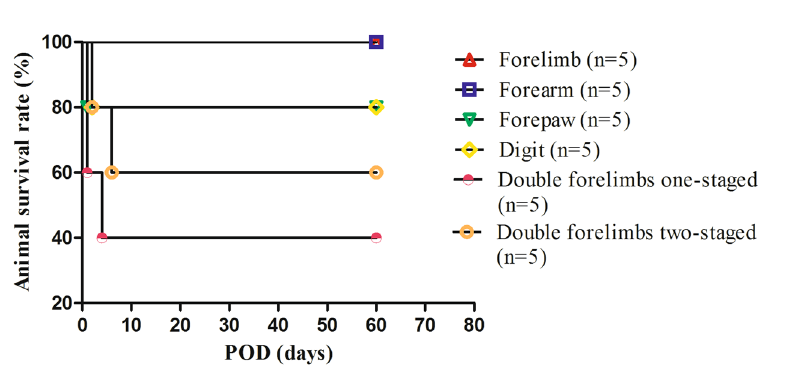
Figure 2. Amputated limbs from different ectopic implantation models sustained viable after operation. ( A ) Forelimb ectopic implantation ( B ) forearm ectopic implantation ( C ) forepaw ectopic implantation ( D ) first digit ectopic implantation ( E ) double forelimbs ectopic implantation.